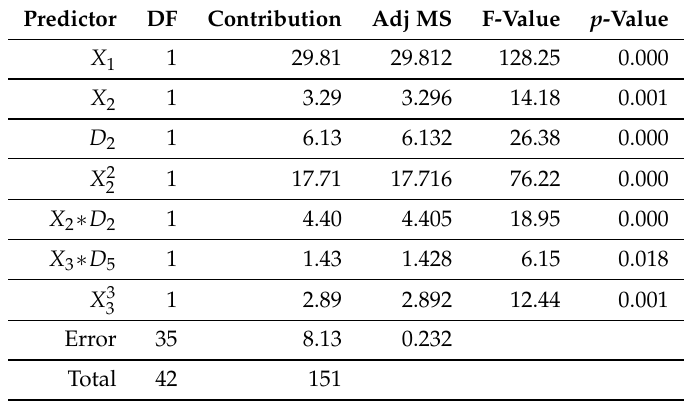
Table 7. ANOVA results for the dummy-variable based